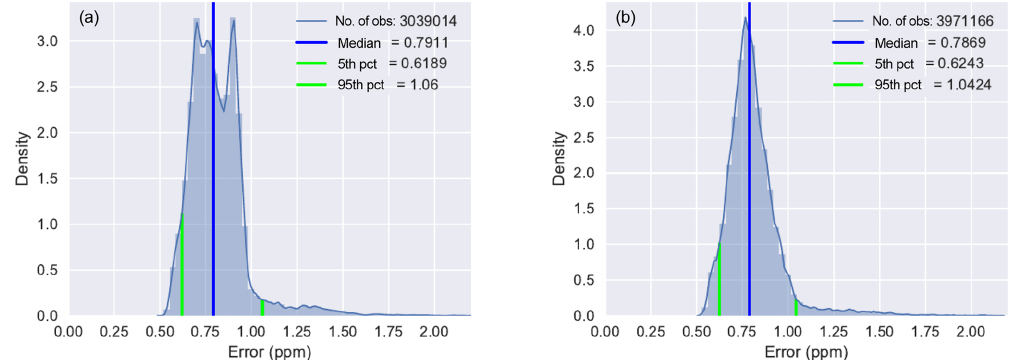
Figure 14. Compared to the baseline strategy (a) , the overall performance of the algorithm-selected strategy (b) is not significantly degraded in the city campaign mode.